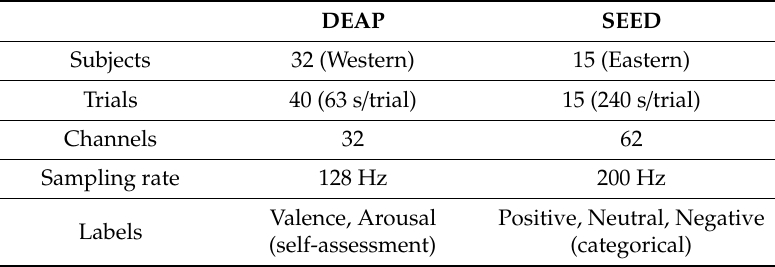
Table 1. Comparison of the two